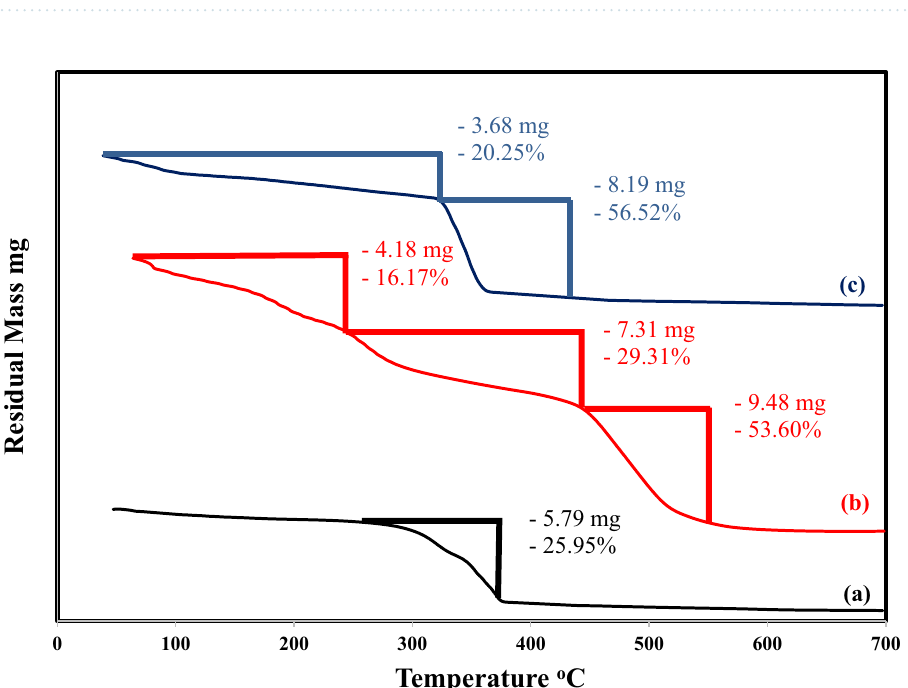
Figure 6. TGA thermograms ( a ) Fe 0.75 Cu 0.25 -BDC MOFs, ( b ) Alg-MoO 3 /GO and ( c ) Fe 0.75 Cu 0.25 -BDC@Alg-